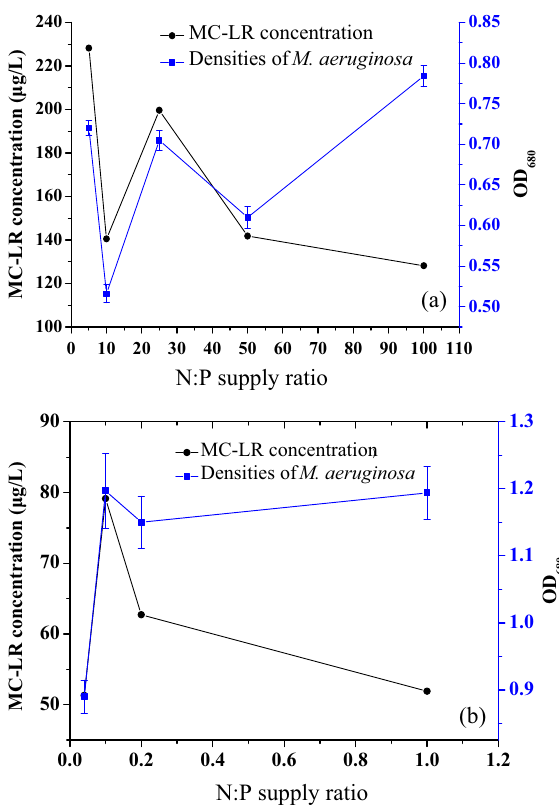
Figure 3: The variation of MC - LR concentration and densities of M. aeruginosa cultured under ( a ) di ff erent N and constant P and ( b ) constant N and varying P.